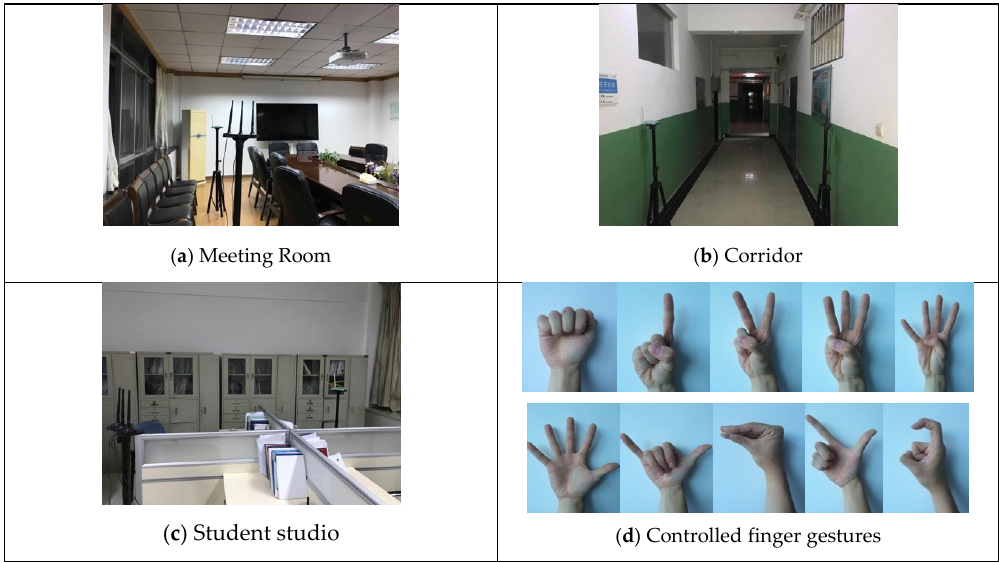
Figure 8. Experimental setup.